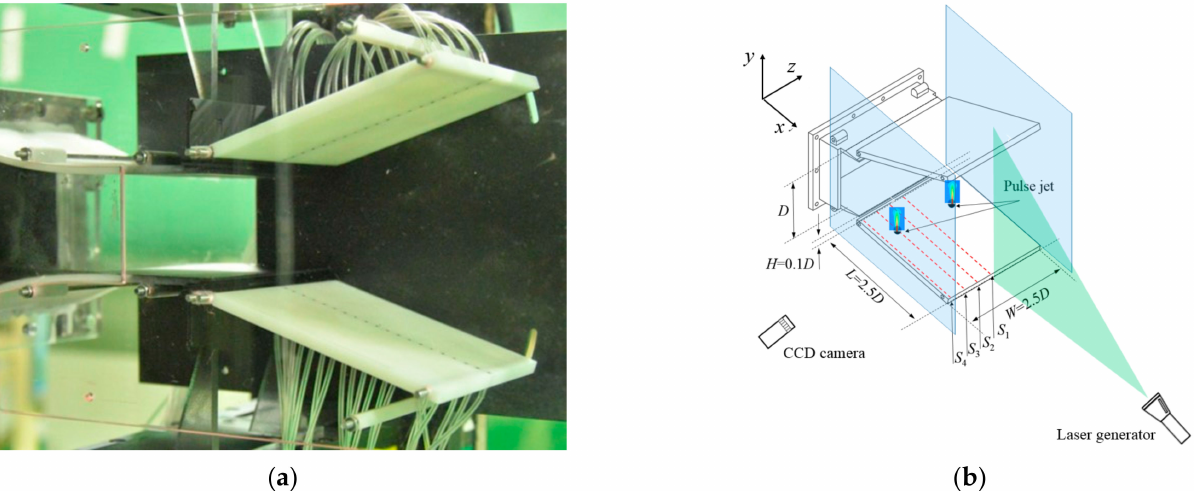
Figure 2. The Coanda effect nozzle model and structural dimension schematics. ( a ) The Coanda effect nozzle model in PIV Layout; ( b ) structural dimension of model and section diagram of PIV